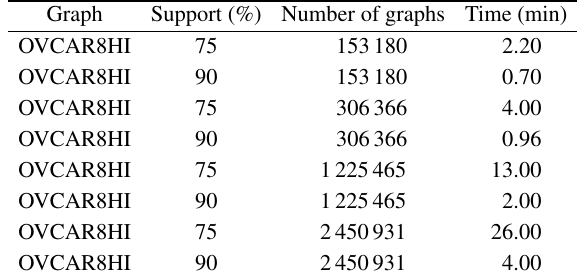
Table 9 SparkFSM [27] performance analysis on large undirected datasets (time in